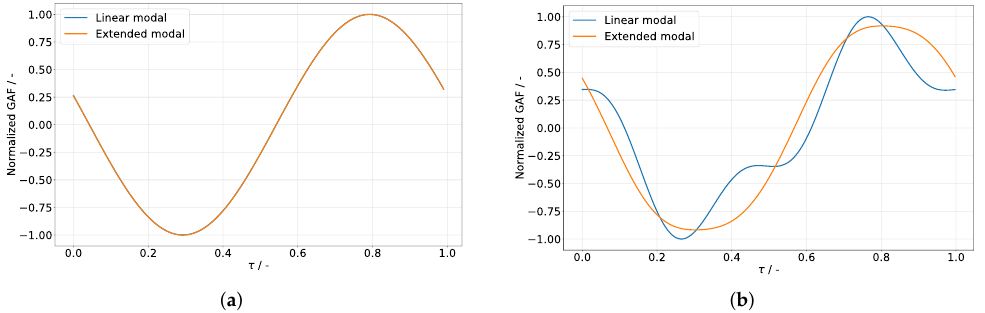
( 1,1 ) ; ( b ) Q ( 1,2 ) ; ( c ) Q ( 2,1 ) ; hh hh hh